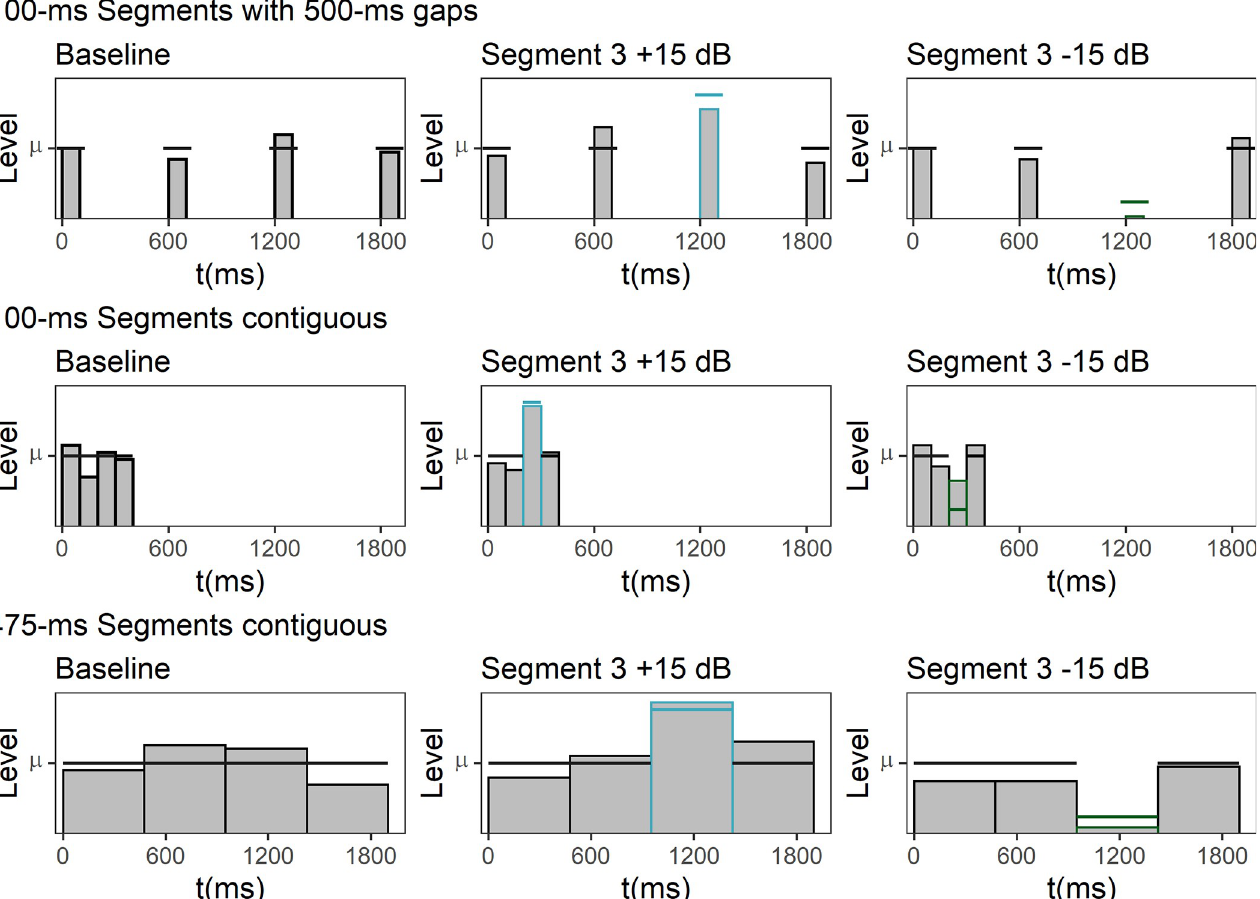
Fig 5. Experiment 3. Level profiles in the nine different conditions. The horizontal lines in each panel display the mean sound pressure level of the distribution from which the segment levels were drawn. The bars display the randomly selected segments levels within an example trial.